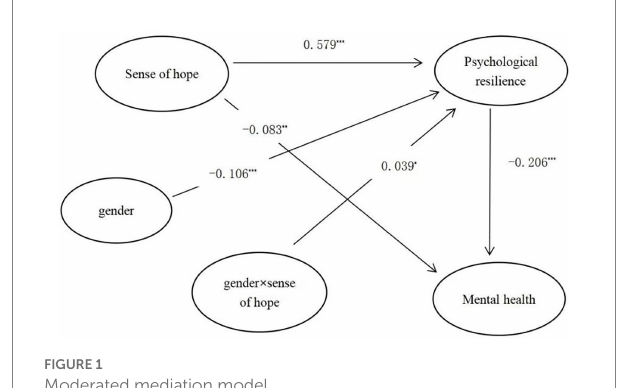
FIGURE 1 Moderated mediation model.